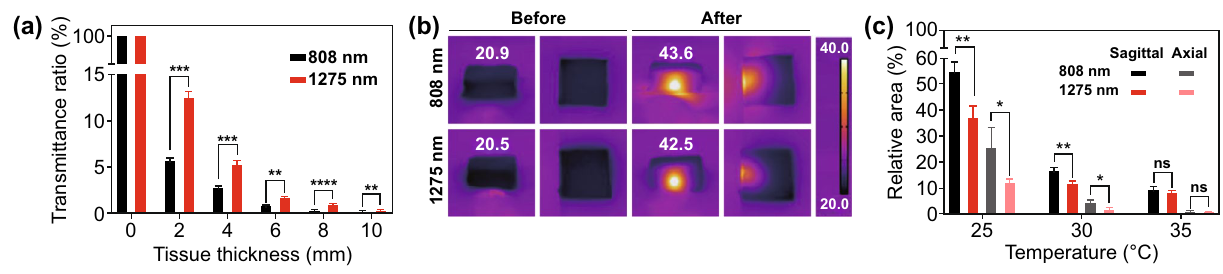
Fig. 2 Transmittance and scattering effect of 808 and 1275 nm laser to porcine muscle. a Quantitative result of remained intensity ratio through porcine muscle of different thicknesses. b Thermal images of porcine muscle tissues after 808 or 1275 nm laser irradiation and c quantitative results of the area above certain temperatures. * p < 0.05, ** p < 0.001, *** p < 0.001, **** p < 0.0001; Student’s t test. The error bars represent standard deviations ( n = 3 per